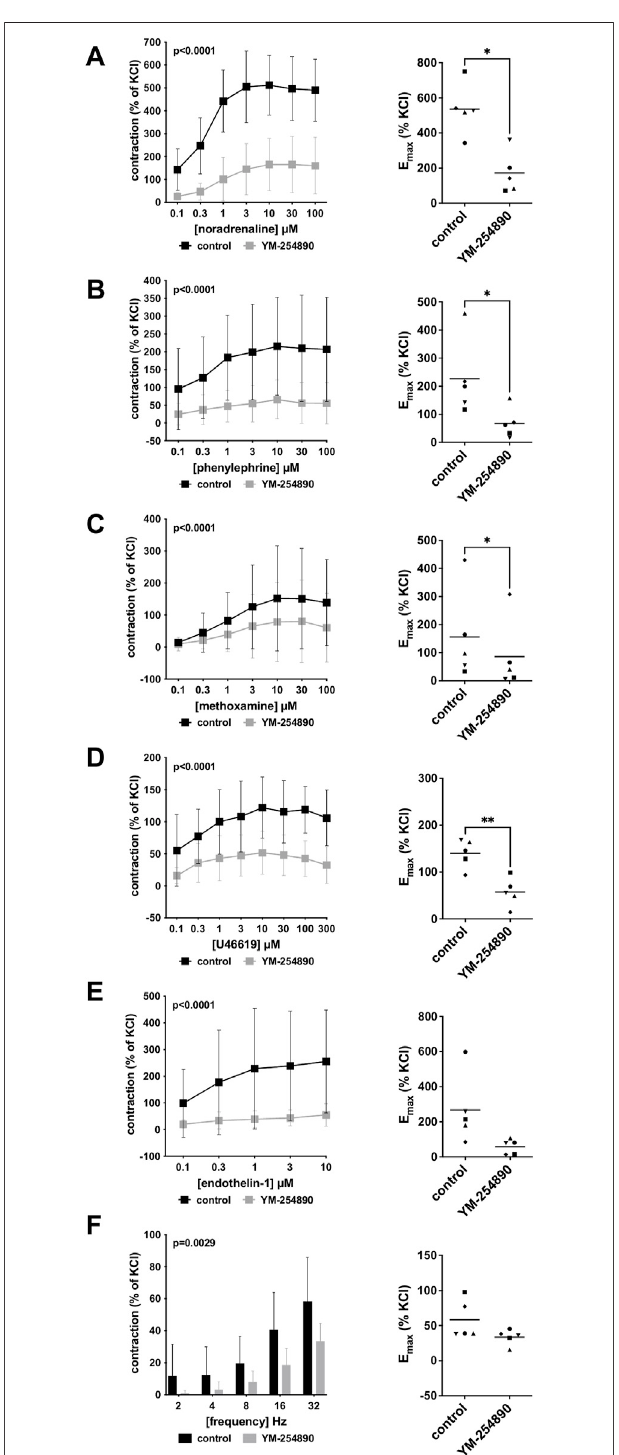
FIGURE 5 | Effects YM-254890 on adrenergic and non-adrenergic, and EFS-induced neurogenic contractions of porcine renal interlobar artery tissues. Adrenergic contractions were induced by the α 1-adrenoceptor agonists noradrenaline (A) , phenylephrine (B) , and methoxamine (C) , while non-adrenergic contractions were induced by thromboxane A2 analog